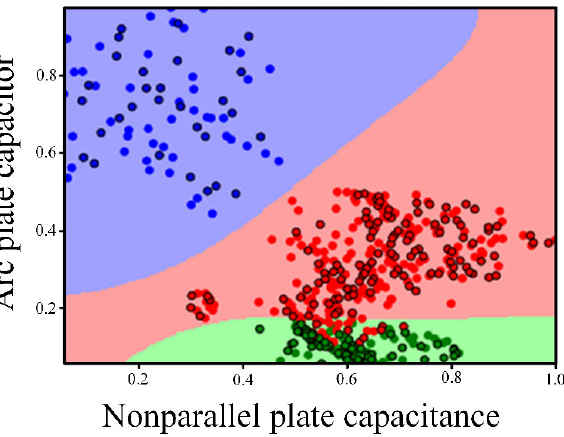
Figure 13. Qualitative classification results of wear particles under actual working